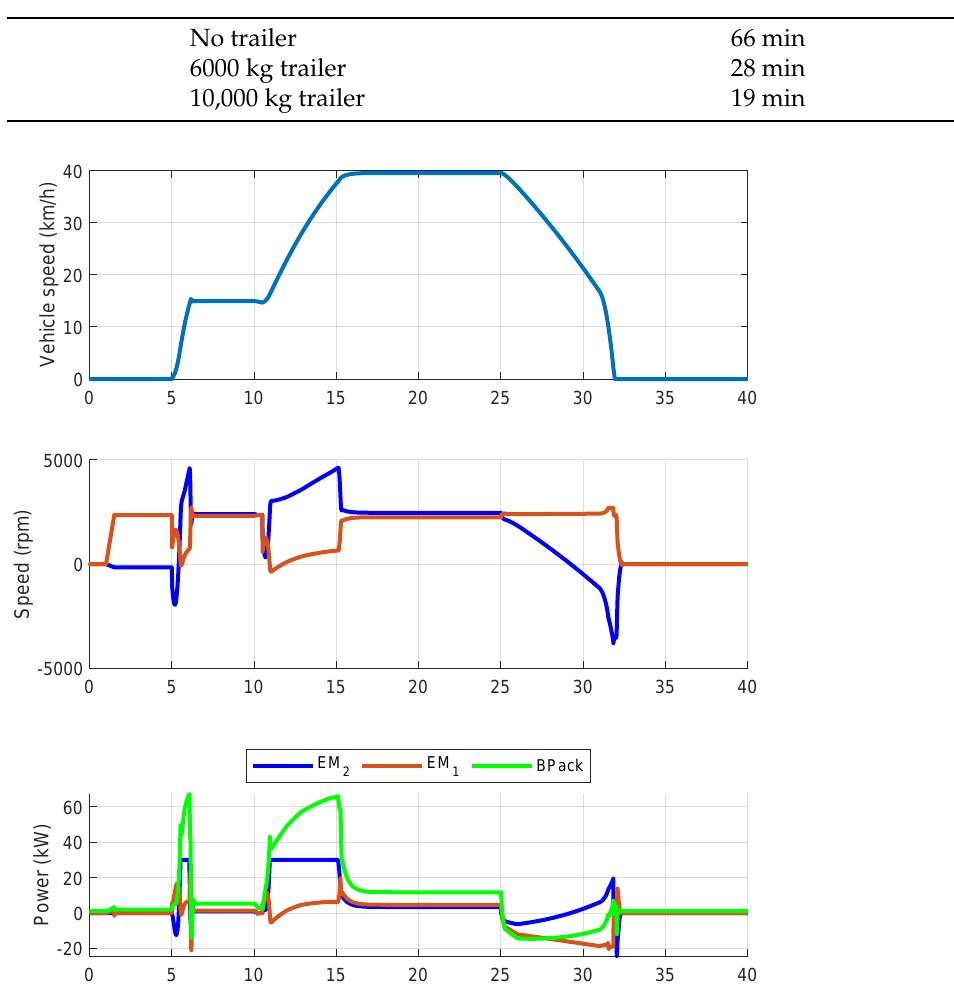
Table 10. HeCVT endurance in full electric mode: constant speed 40 km/h with different trailer payloads.